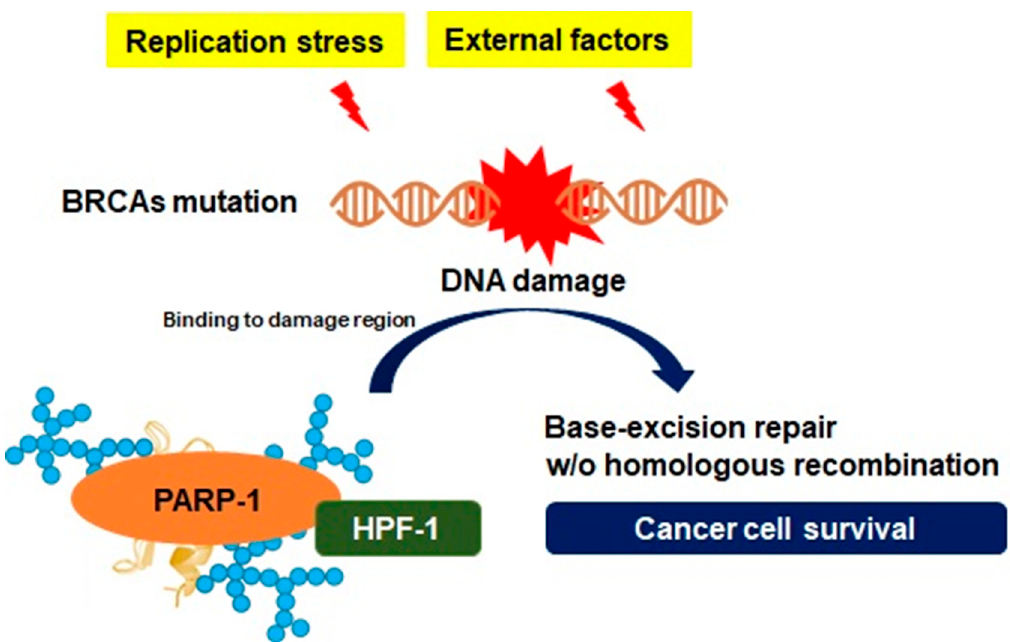
Figure 4. Adaptation of genomic instability depending on PARP-1. Silencing or detrimental mutations in the DNA damage response genes, such as the breast cancer susceptibility gene (BRCA), are associated with genomic instability to achieve uncontrolled proliferation for aggressive growth in cancer cells. However, such an environment could be an unfavorable condition for cancer cell survival, where persistent DNA damage is induced. However, PARP-1 can facilitate DNA repair in response to replication stress or external factors by maintaining the open form of chromatin structures following PAR synthesis on acceptor proteins, such as histone PARylation factor 1 (HPF-1), which is available to the adaptation to genomic instability.